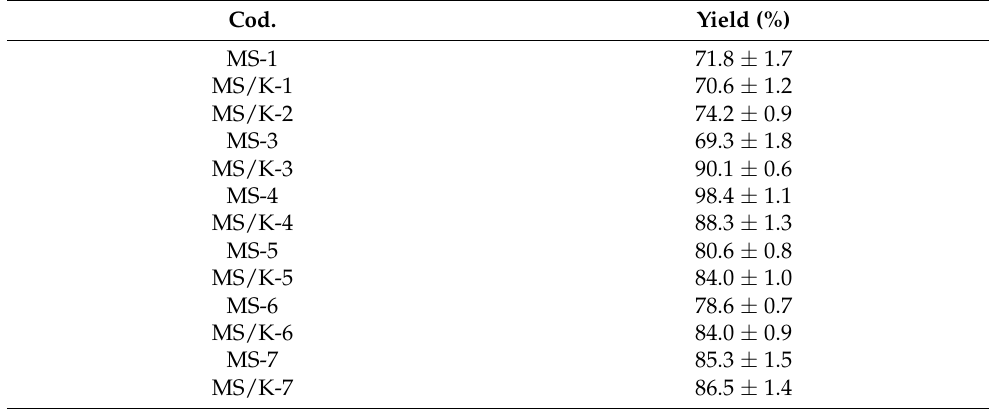
Table 3. Effects of the variations in synthesis conditions on MS and MS/K yields. Reported values represent the mean ± SD (n = 3).